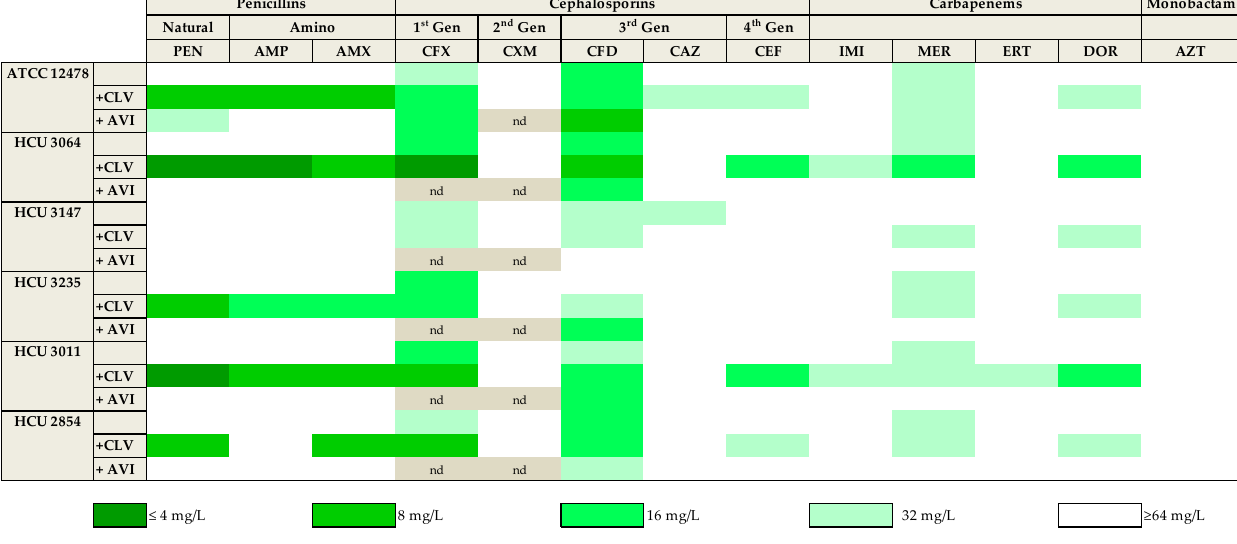
Figure 1. Heat map representation of the activity of thirteen selected β -lactams against Mkn clinical strains. MIC values (mg/L) were calculated in the presence/absence of a fixed 4 mg/L dose of clavulanate and avibactam in Middlebrook 7H9 broth plus ADC. Clavulanate was the most effective β -lactamase inhibitor. Amoxicillin–clavulanate and cefadroxil were the more active beta-lactams. PEN: penicillin; AMP: ampicillin; AMX: amoxicillin. CFX: cefadroxil; CXM: cefuroxime; CFD: cefd-